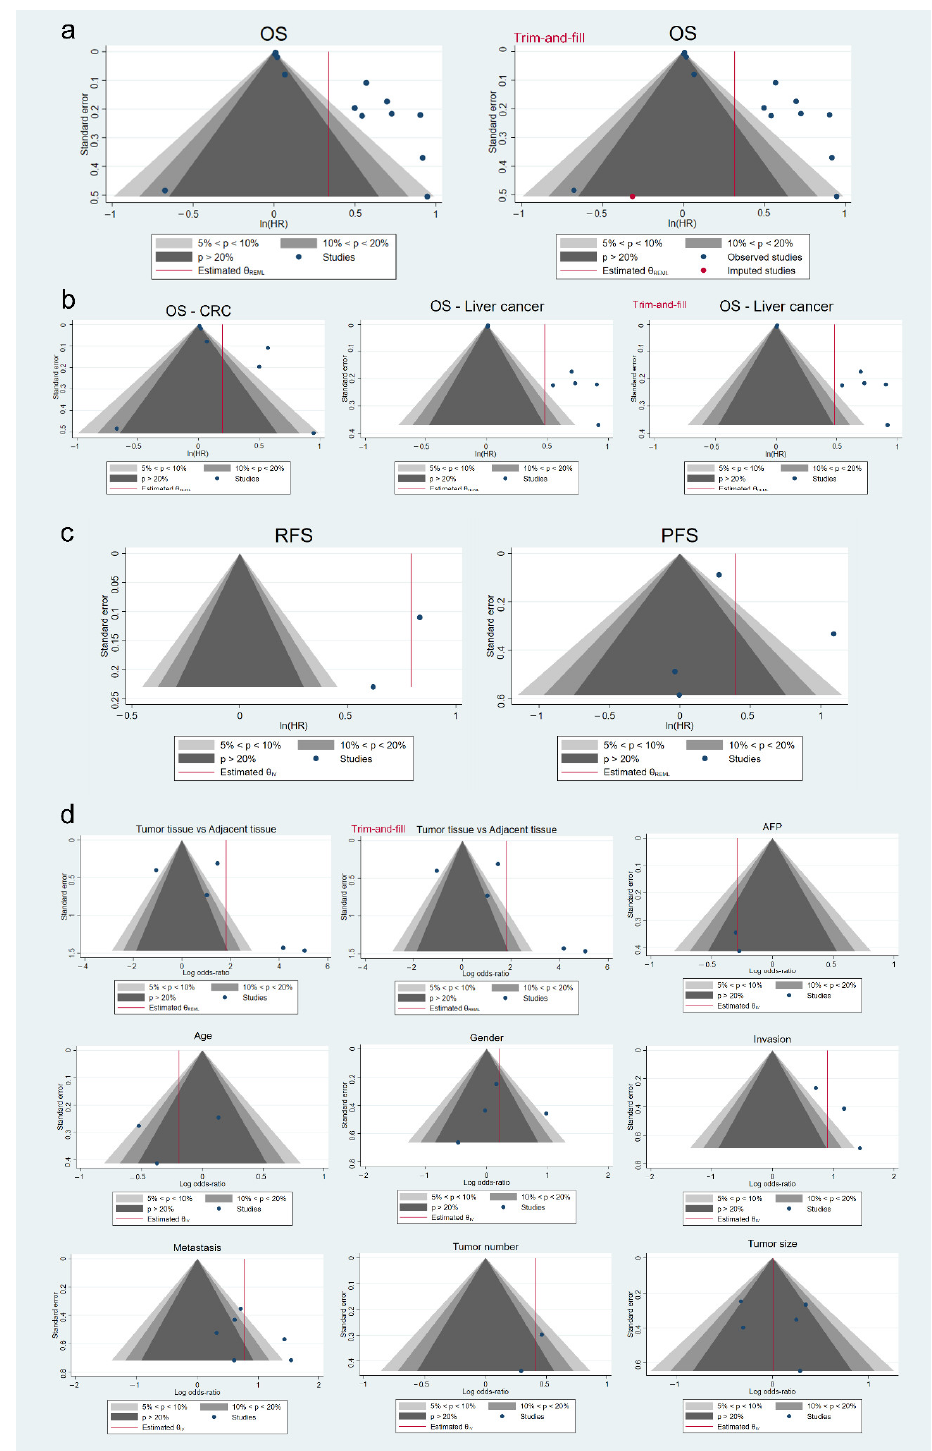
Figure 5. Publication bias evaluation of the correlation of NRP1 overexpression with ( a ) OS for all included studies, ( b ) OS separately for CRC and liver cancer studies, ( c ) RFS and PFS, and ( d ) tumor pathogenesis and the assessed clinicopathological features by funnel plot asymmetry with contour- enhanced funnel plots. Trim-and-fill funnel plots are also included for ( a ) general OS, ( b ) OS in liver cancer studies and ( d ) tumor pathogenesis. AFP, alpha-fetoprotein; CI, confidence interval; CRC, colorectal cancer; HR, hazard ratio; IV, Inverse Variance; OS, overall survival; PFS, progression-free survival; REML, Restricted Maximum Likelihood; RFS, recurrence-free